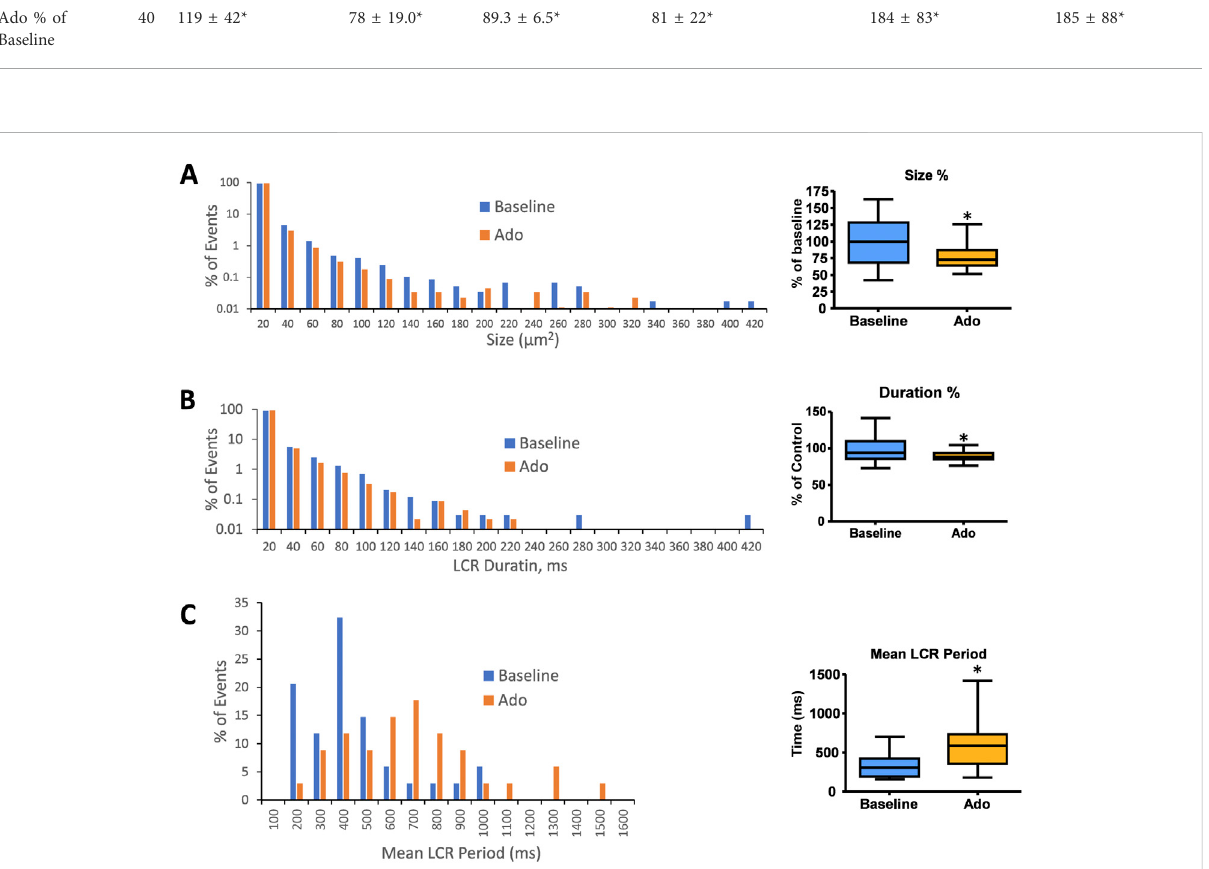
FIGURE 6 HistogramsofLCRsize (A) ,LCRduration (B) ,andmeanLCRperiod (C) percentagedistributionsinallrhythmicSANCbeforeandinthepresence ofadenosine( n = 34). Mean LCR periodwas theaveragedLCR period of 3 – 7cycles at baseline and with adenosinefor each SANC. Mean LCR period also increased in response to adenosine; * p < 0.05 via one-way repeated measures